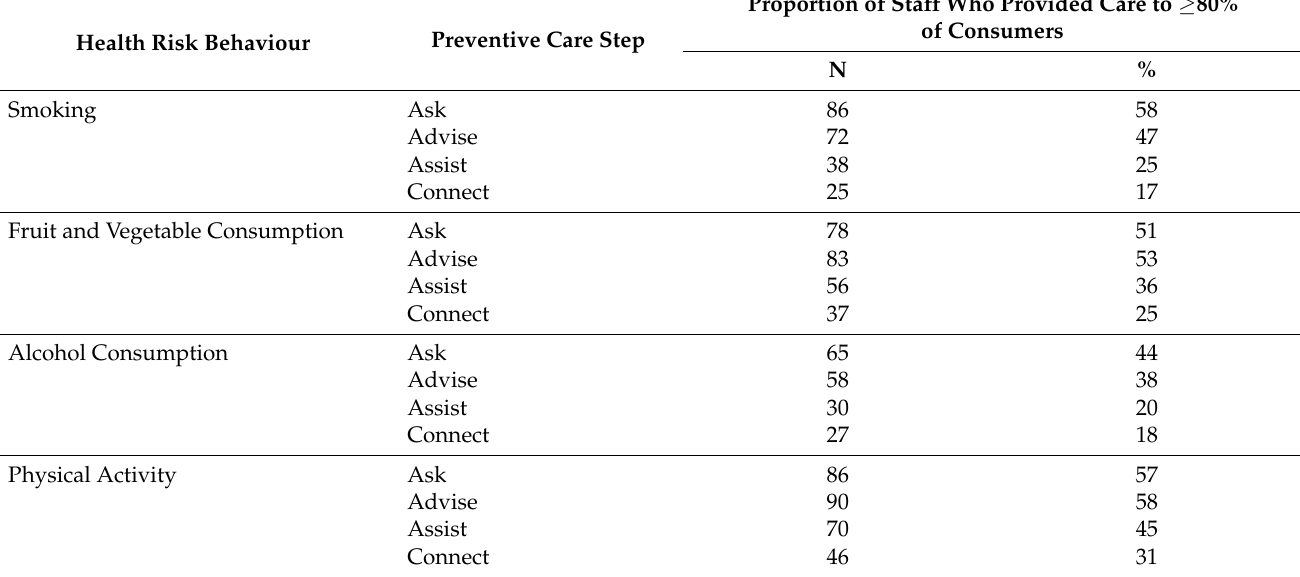
Table 2. Provision of care to ≥ 80% of consumers, by health risk behaviour and preventive care